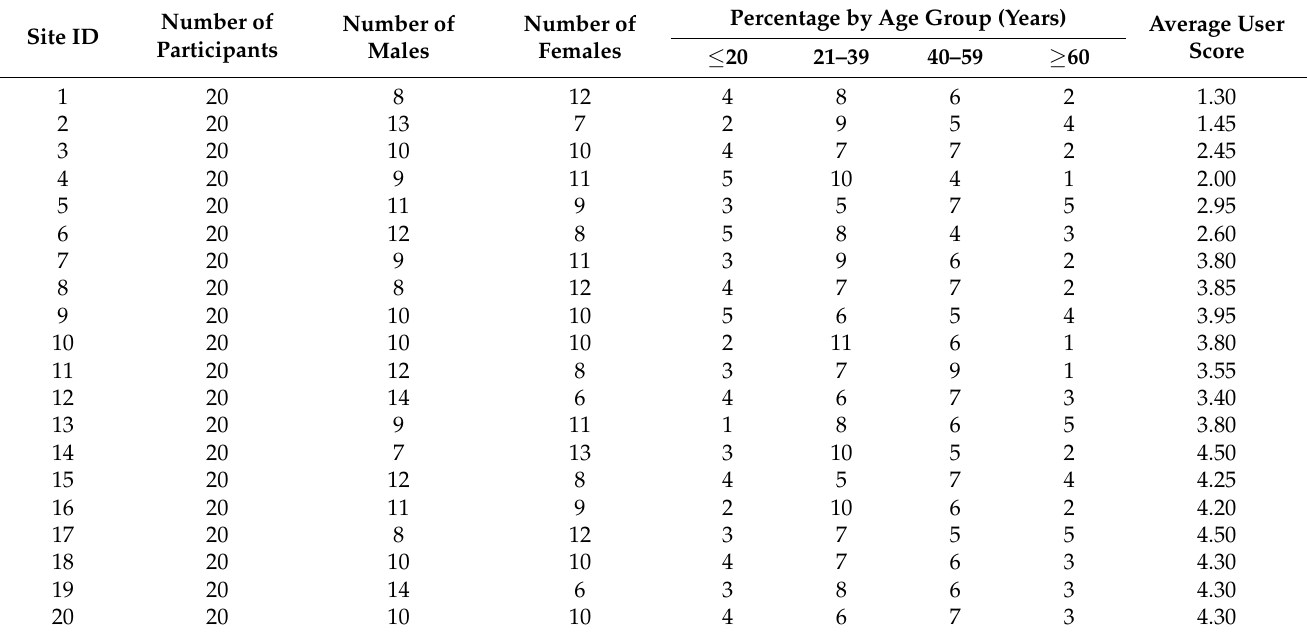
Table 3. Gender and Age Distribution and Average User Score of Each Survey Site.